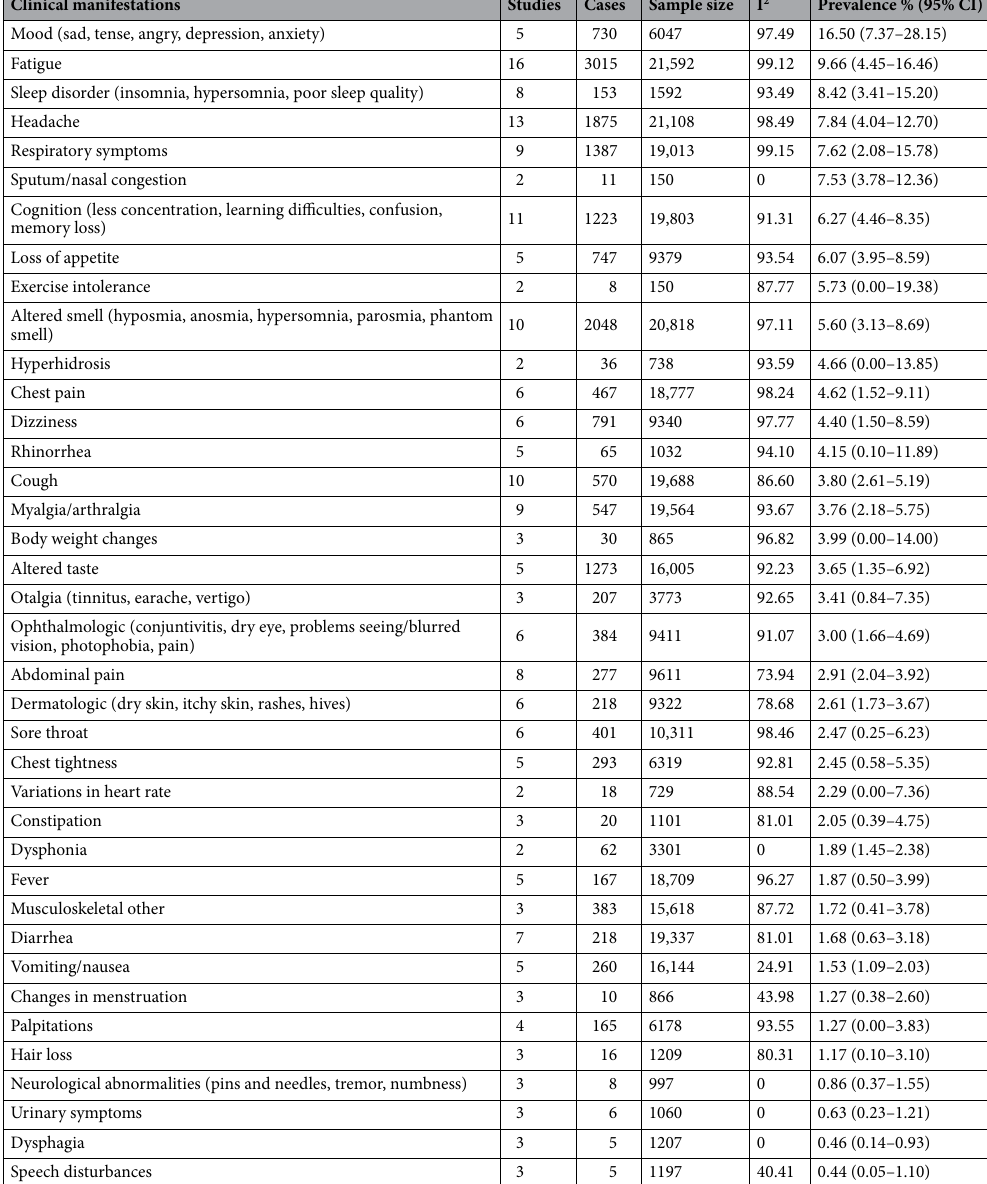
Table 2. Pooled prevalence of symptoms in children and